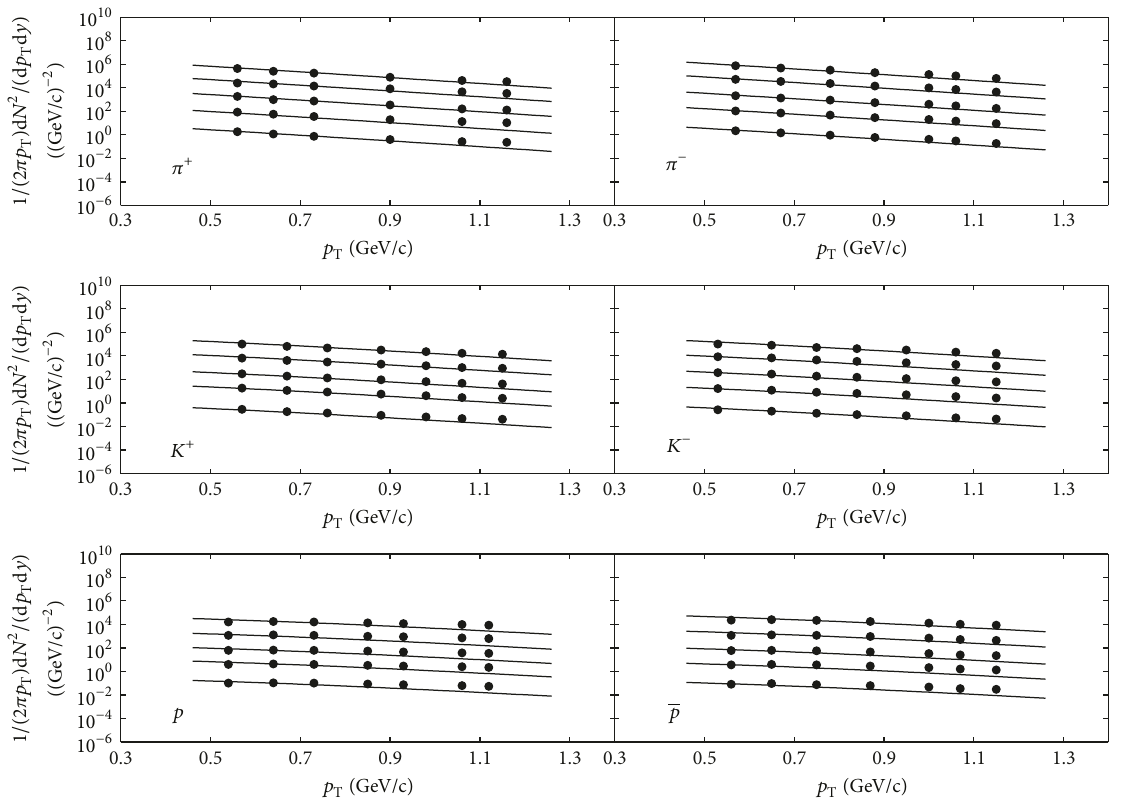
Figure 2: The centrality dependences of transverse momentum distributions of identified charged particles produced in Au-Au collisions at √𝑠 NN = 200 GeV. The solid dots are the experimental data [19]. The solid curves are the hydrodynamic results of (9). The centrality cuts counted from top to bottom in each panel are 0–10% (×10 4 ) , 10–20% (×10 3 ) , 20–40% (×10 2 ) , 40–60% (×10 1 ) , and 60–92% (×10 0 ) , respectively.